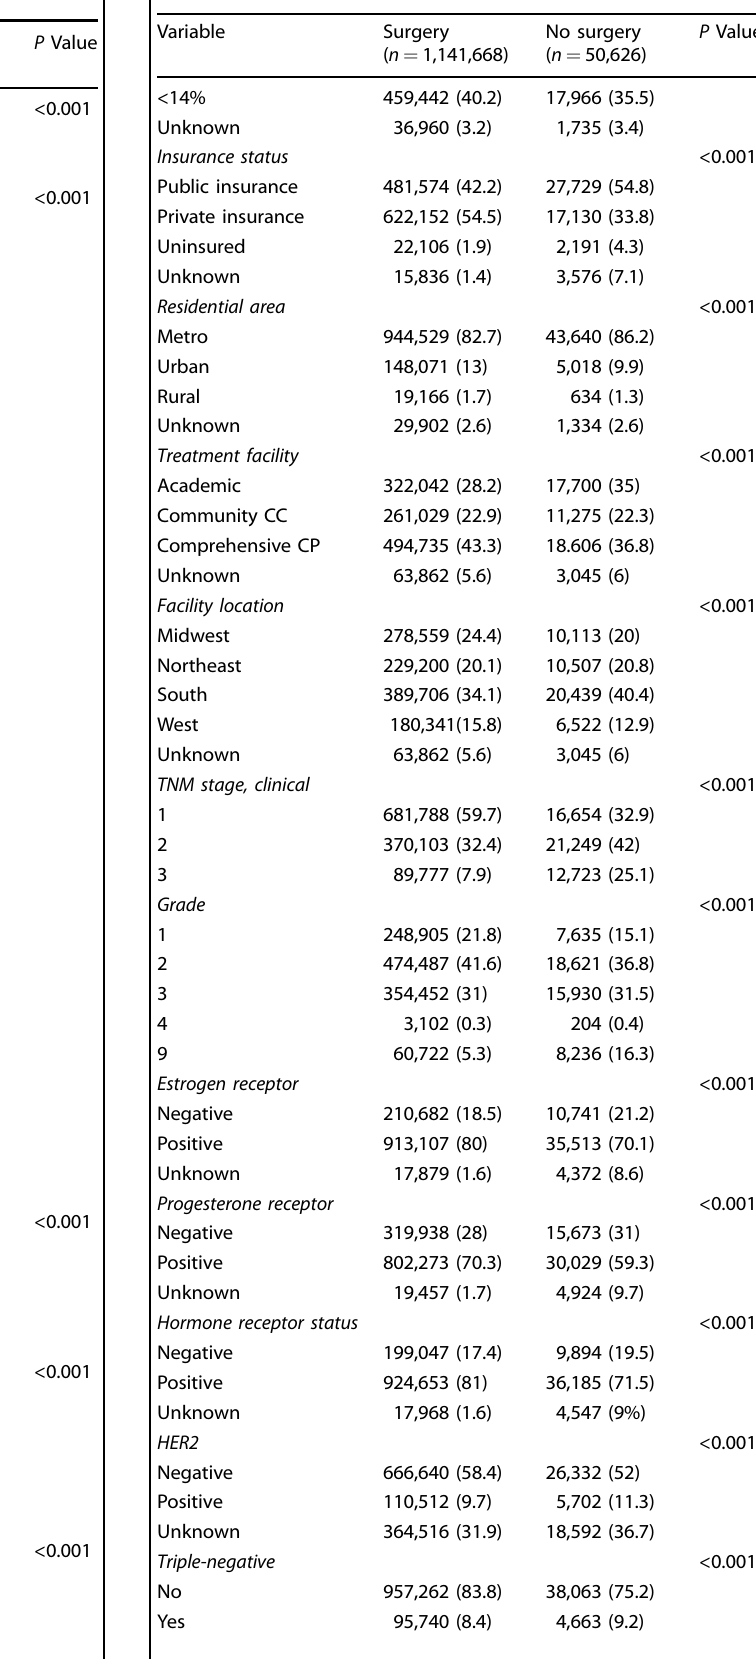
Table 1. Patient, tumor, and treatment